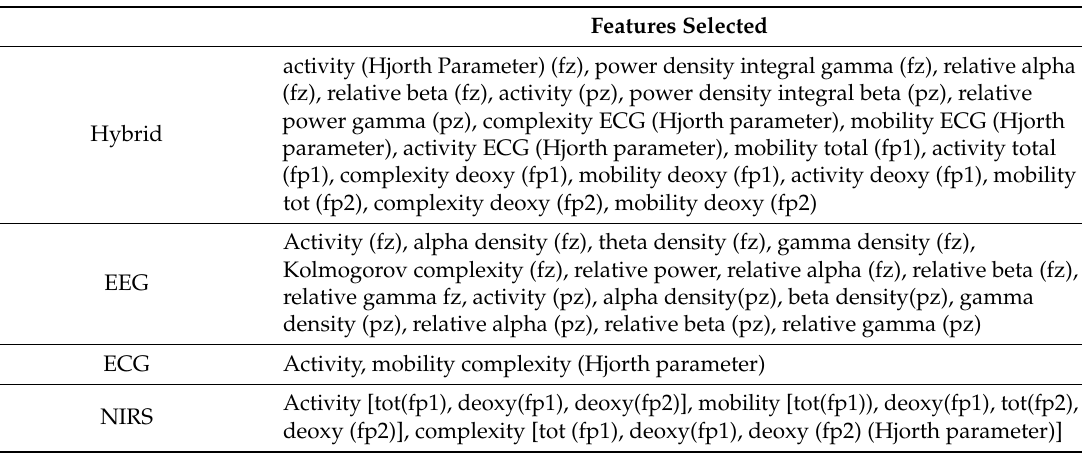
Table 10. Features selected on the basis of CFS attribute evaluator.